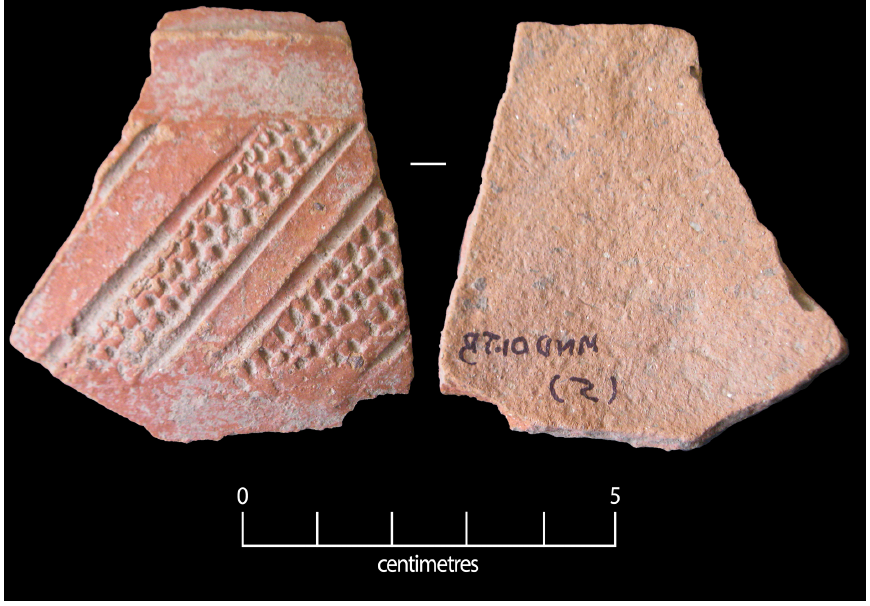
Figure 6: External and internal surfaces of a decorated Class 2 variant 2 body